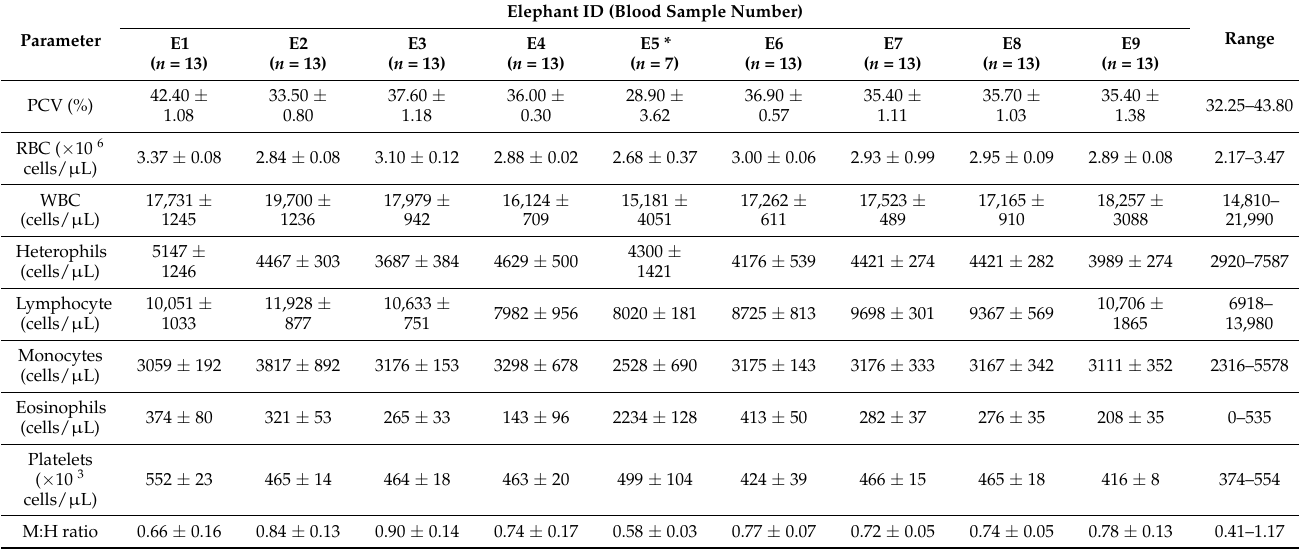
Table 3. Mean ( ± SEM) hematology values of individual elephants in the study.